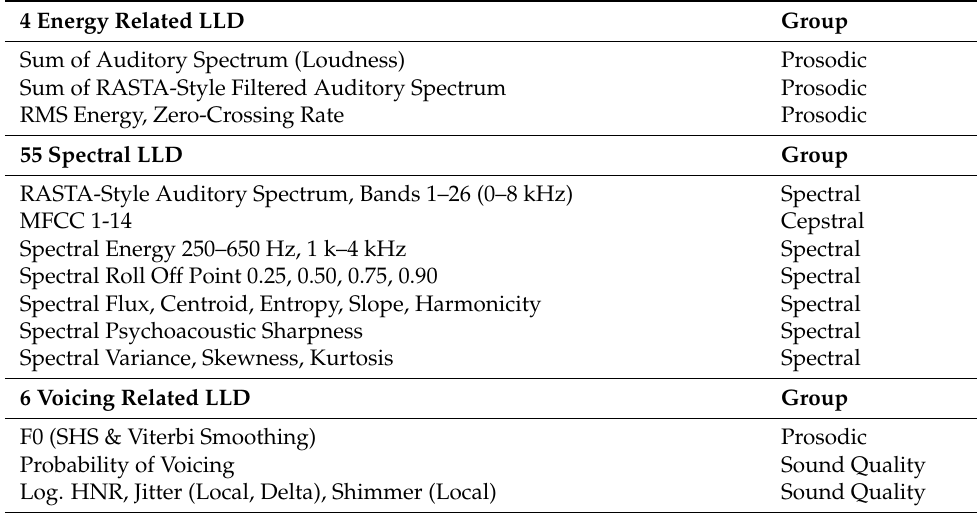
Table 1. The 130 LLD features, including 65 LLD and 65 ∆ LLD features [46]. 4 Energy Related